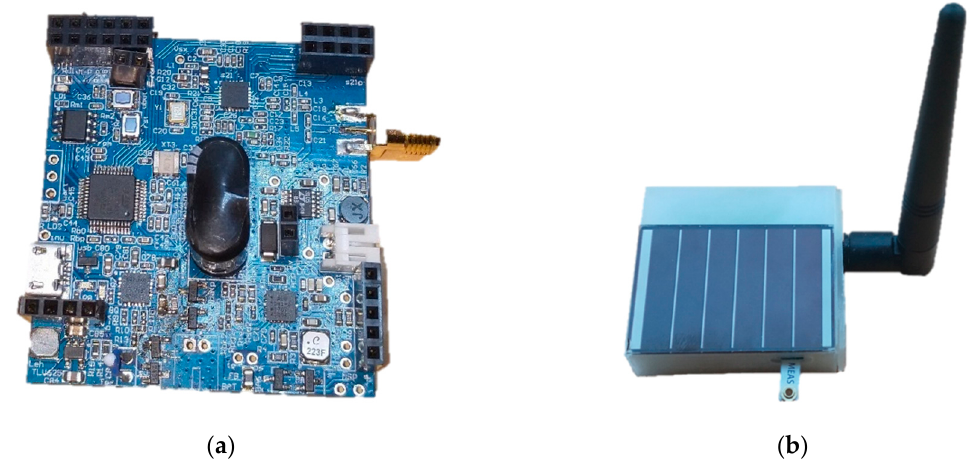
Figure 3. ( a ) Tag board; ( b ) Fully assembled autonomous active tag.